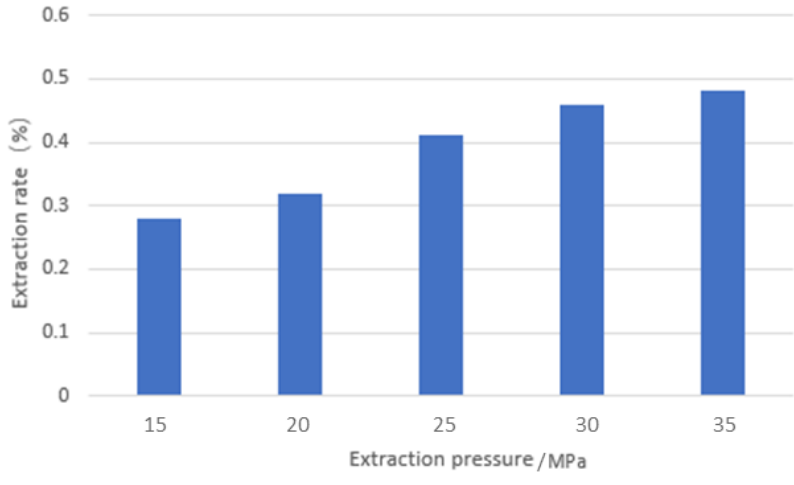
Figure 4. Effect of the extraction pressure on the extraction rate.